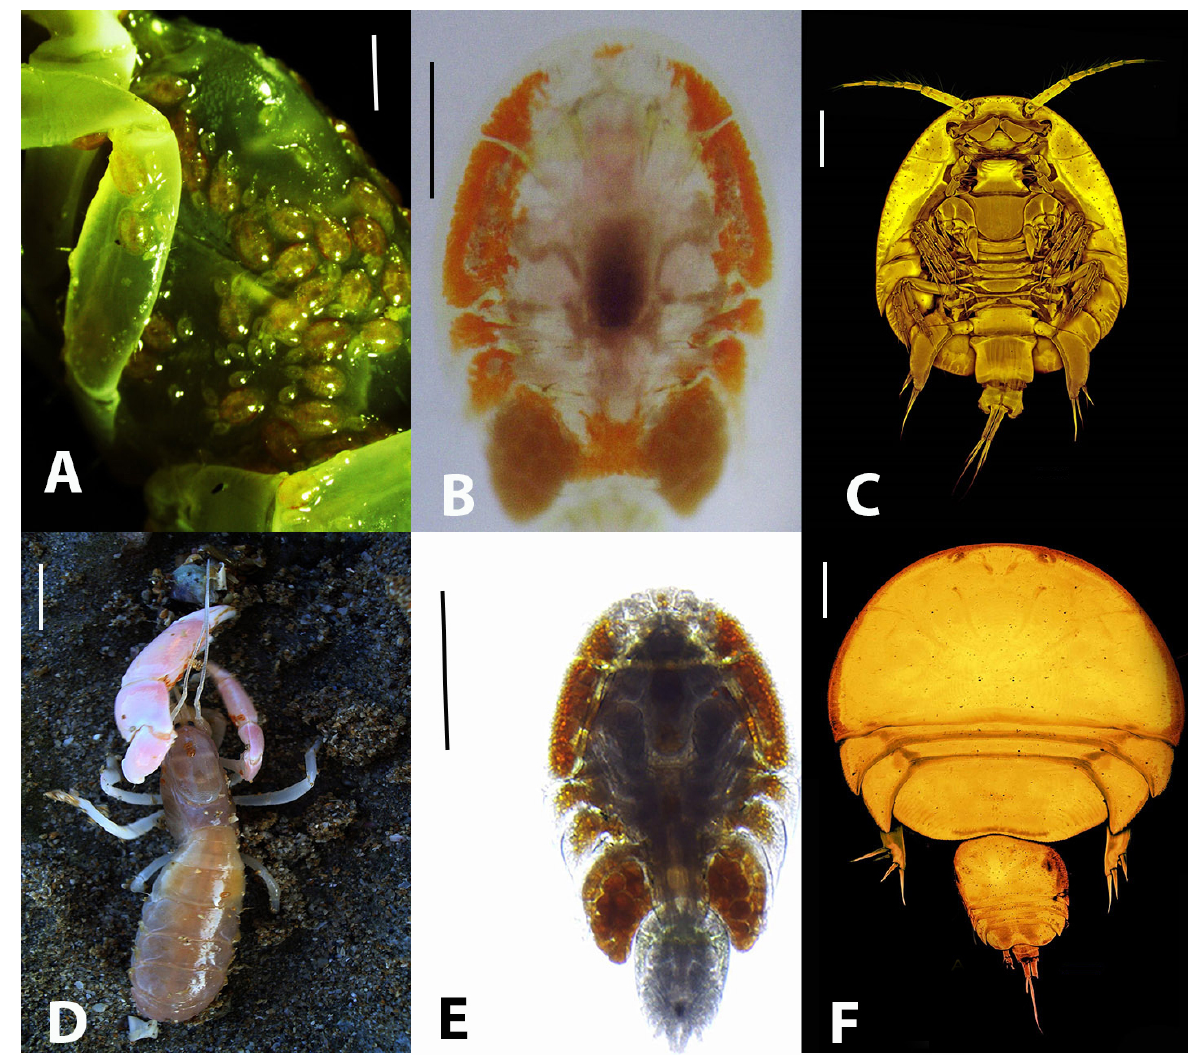
Figure 1. A , Callianidea typa , lateral view of cephalothorax with copepods; B , Clausidium persiaensis , habitus, ventral view, female; C , C. persiaensis , confocal laser scanning microscopy maximum projections; D , Neocallichirus jousseaumei , habitus, dorsal view; E , Clausidium persiaensis , habitus, ventral view; F , C. iranensis , confocal laser scanning microscopy maximum projections, dorsal view. Scale bars: A , 1 mm; B , 0.5 mm; C , 100 µm; D , 1 cm; E , 1 mm; F , 100